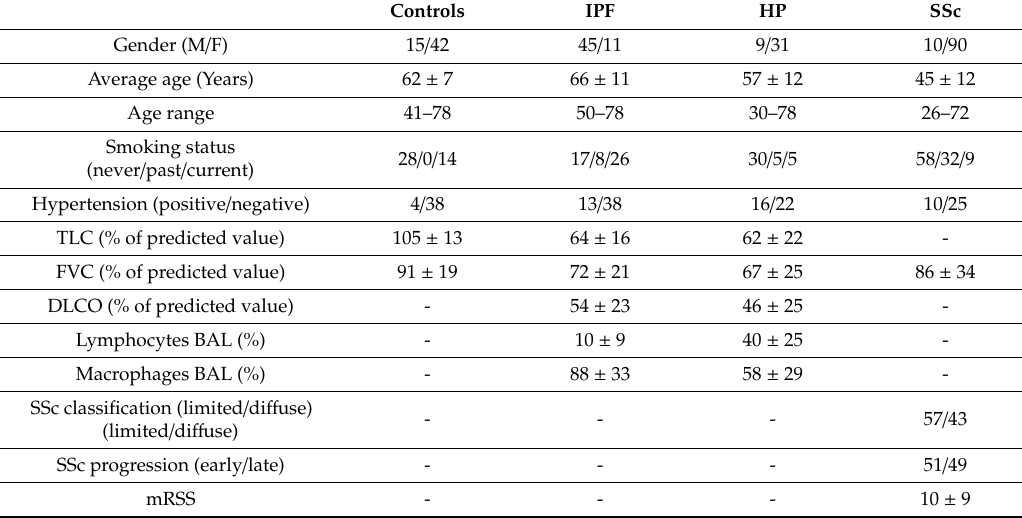
Table 1. Patients and controls characteristics.